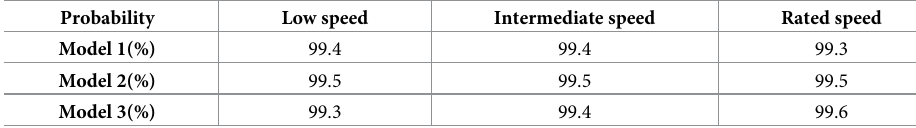
Table 5. Probability comparison of different speed matching